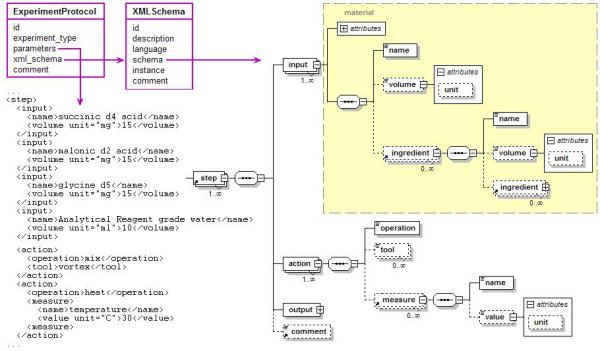


An embedded XML document. Embedding an XML document representing an experimental protocol into the MeMo database. The XMLSchema entity is not included in the model (Figures 1 and 2), because it is a part of the implementation. The given schema is depicted using XMLSpy 2005 .